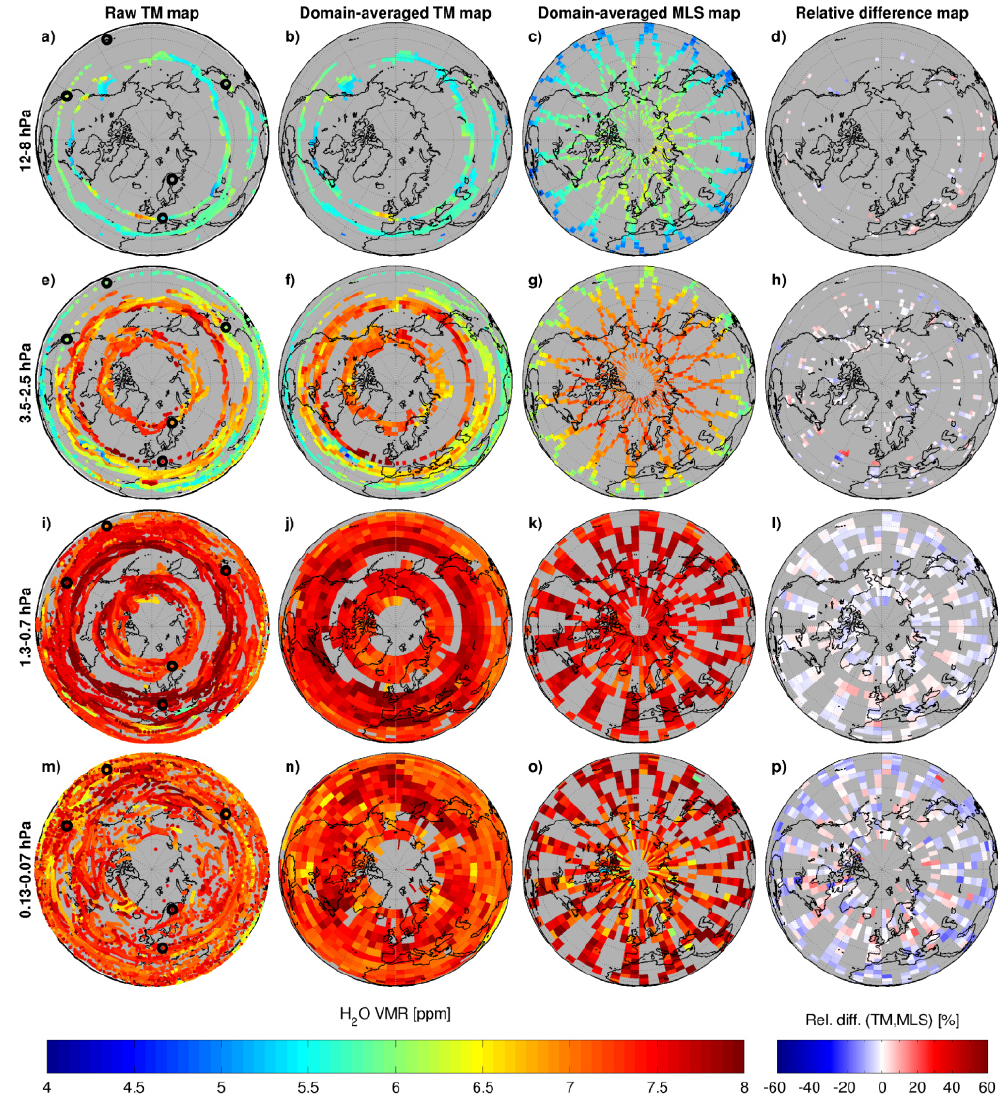
Figure 5. Case C: same as Fig. 3, except for 21 June 2012, 12:00UTC close to the June